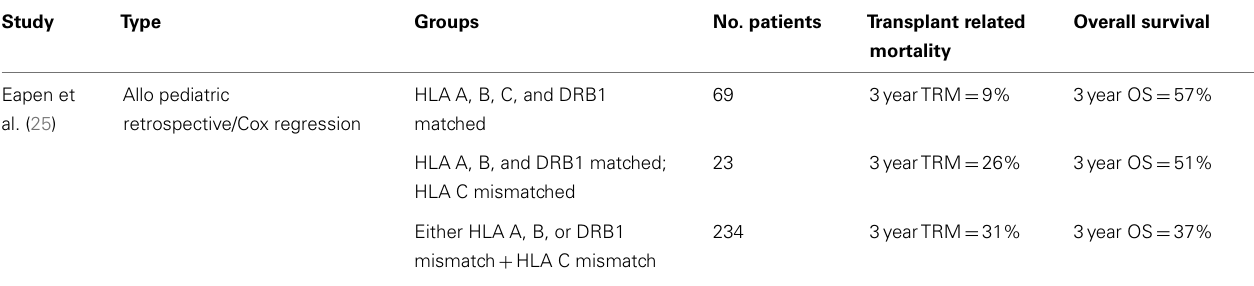
Table 3 | Retrospective analysis of HLA C typing in